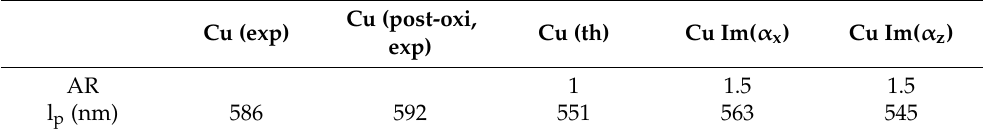
Table 2. Experimental wavelength positions of the LSPR for Cu and Cu post-ox NPs, and theoretical positions of the LSPR calculated for Cu NPs in vacuum. The results for AR = 1.5 are, respectively, maxima of Im ( α x ) and Im ( α z